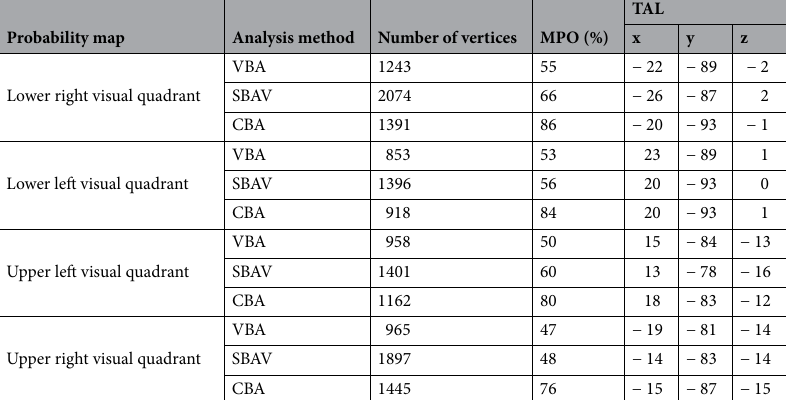
Table 5. Extent of probability maps. For each visual quadrant and analysis methods, we counted the number of vertices in the corresponding probability maps exceeding the threshold of 10% probability of activation overlap. For VBA, maximum probability of activation overlap (MPO) was 55%. For SBAV, maximum probability of activation overlap was 66%. For CBA, maximum probability of activation overlap was 86%. We also extracted the Talairach (TAL) coordinates of the vertex showing MPO for each quadrant and each data set.